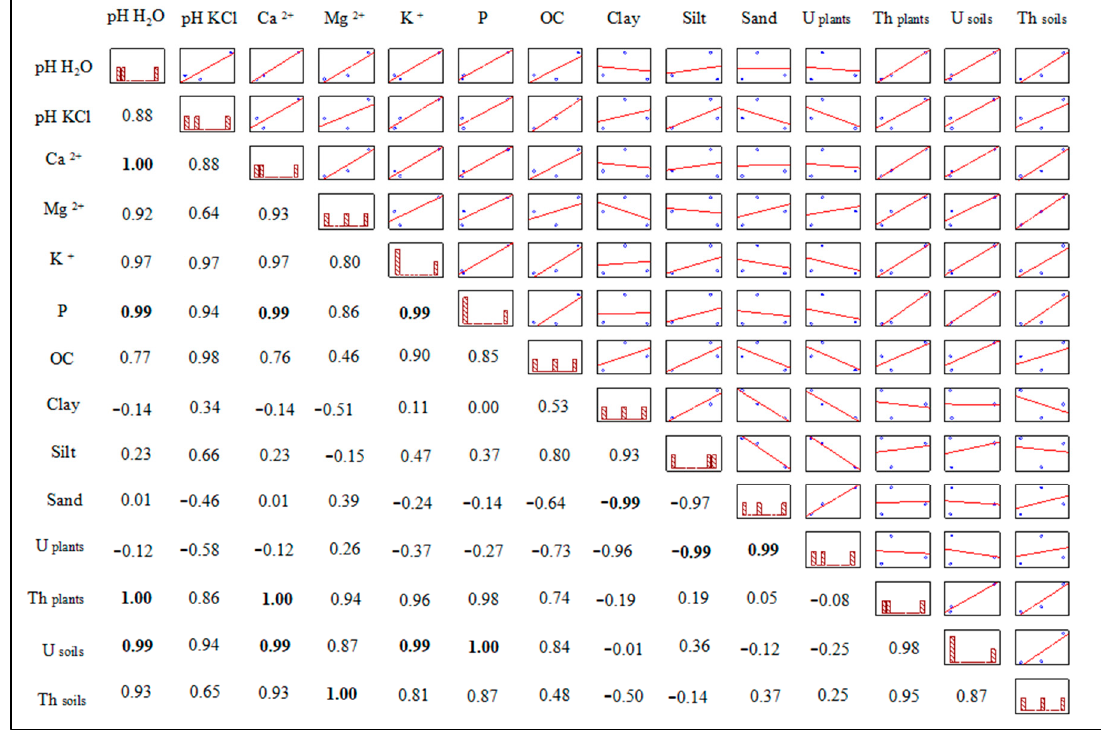
Figure 5. Pearson’s correlation coefficients between uranium and thorium concentrations and soil attributes. Bold coeffi- cients indicate significant correlation ( p ≤